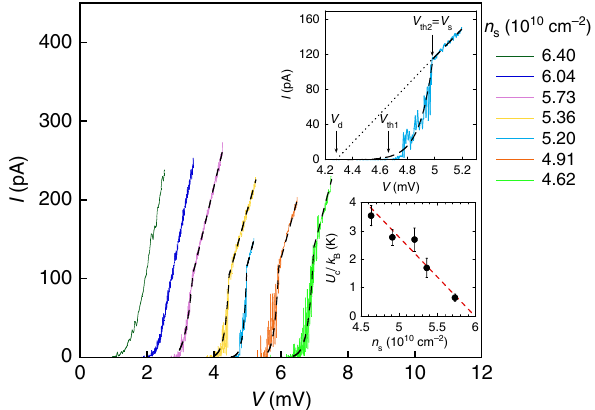
Fig. 1 Voltage-current characteristics. V − I curves are shown for different electron densities in the insulating state at a temperature of 60 mK. The dashed lines are fi ts to the data using Eq. (5). The top inset shows the V − I curve for n s = 5.20 × 10 10 cm − 2 on an expanded scale; also shown are the threshold voltages V th1 and V th2 , the static threshold V s = V th2 , and the dynamic threshold V d that is obtained by the extrapolation of the linear region of the V − I curve to zero current. Bottom inset: activation energy U c vs. electron density. Vertical error bars represent standard deviations in the determination of U c from the fi ts to the data using Eq. (5). The dashed line is a linear fi